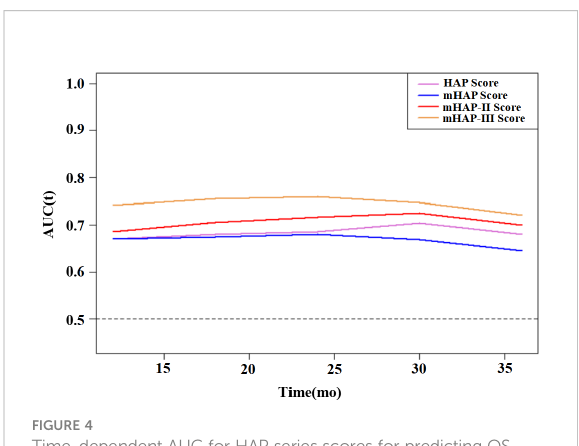
FIGURE 4 Time-dependent AUC for HAP series scores for predicting OS. HAP, hepatoma arterial-embolization prognostic; mHAP, modi fi ed hepatoma arterial-embolization prognostic; OS, overall survival; mo, months; AUC, area under the receiving operating curve.